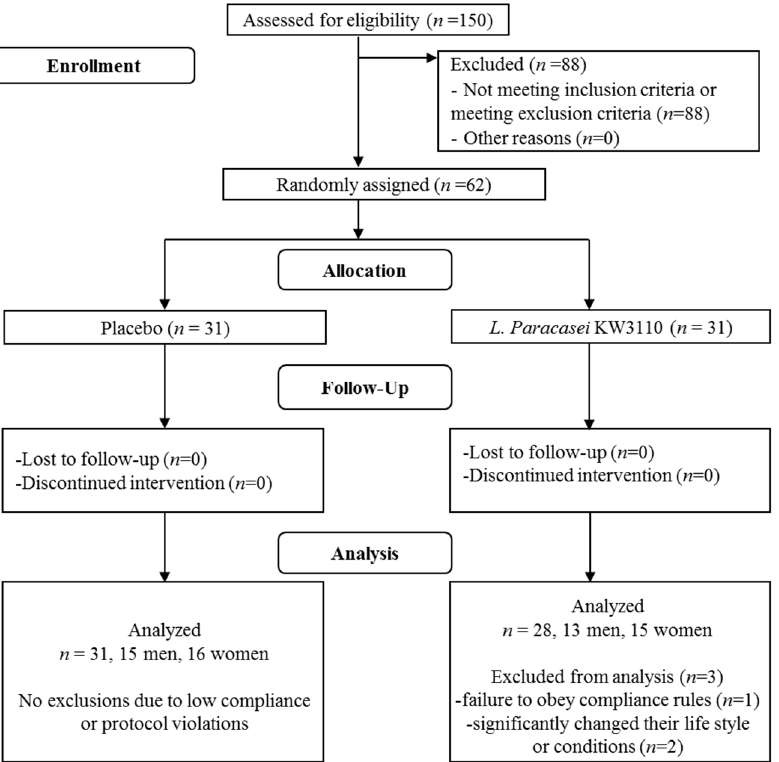
Figure 1. Summary flow diagram of this study. Table 1. Exclusion criteria for the study.